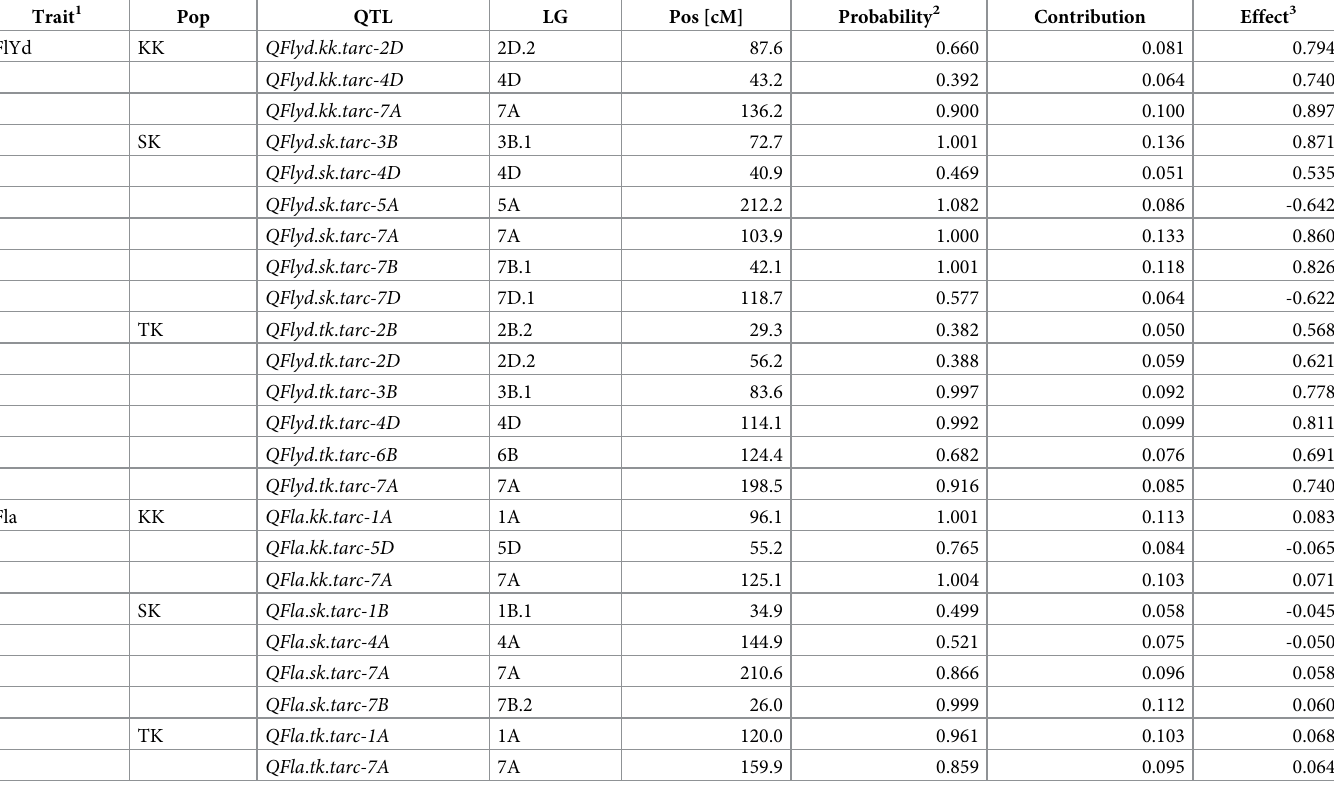
1 FlYd: Flour yield, Fla: Flour color a �